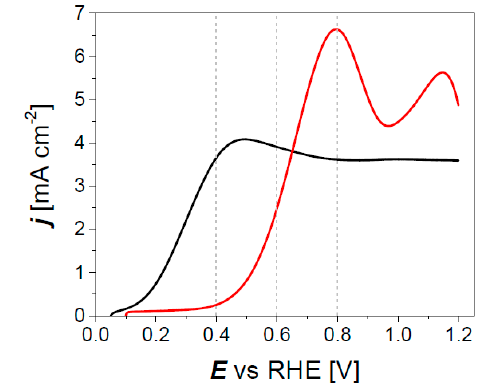
Figure 10. Third stable linear scan voltammetry curves recorded at Pd 3 Au 7 /C catalyst in 0.10 mol L − 1 NaOH electrolyte in the presence of 0.10 mol L − 1 glucose (black line) and 0.10 mol L − 1 gluconate (red